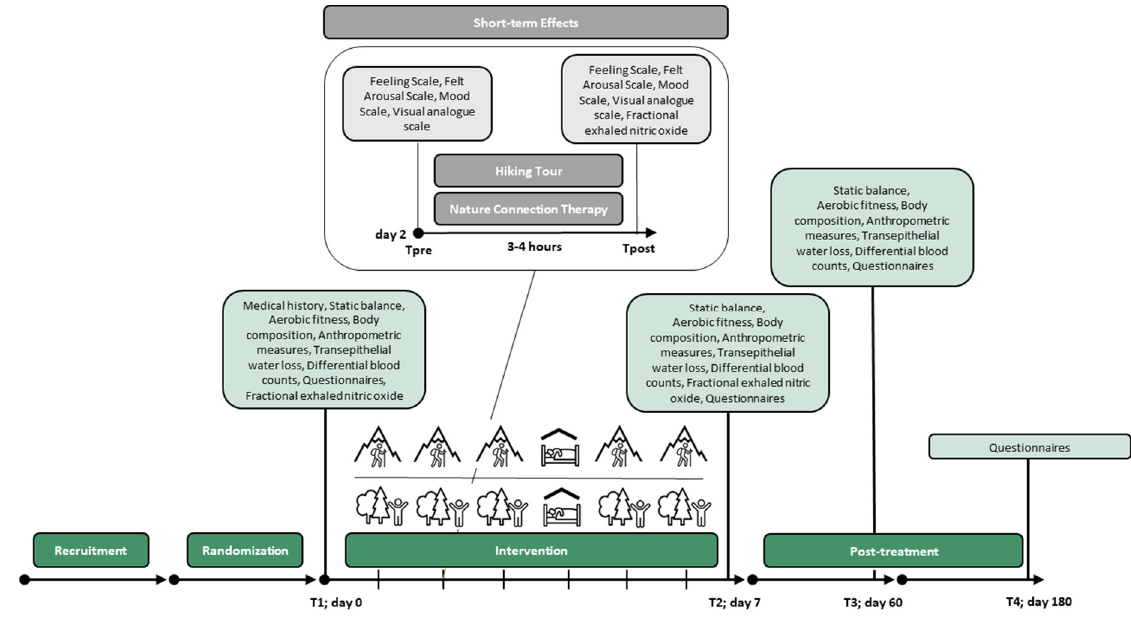
Figure 1. Study schedule